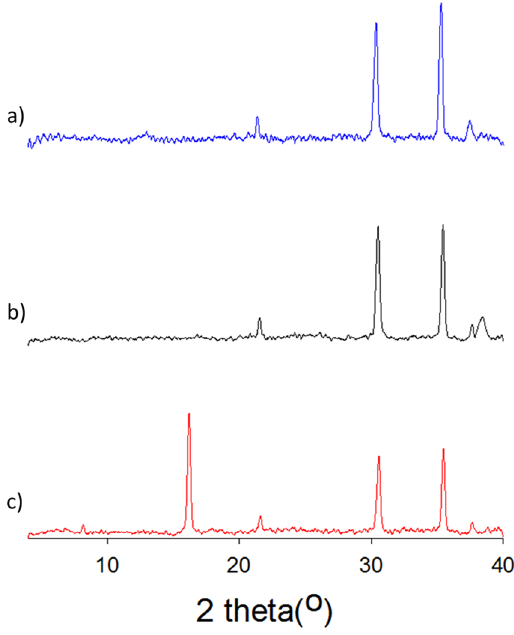
Figure 5. XRD patterns of ( a ) ITO/PEDOT:PSS substrate; ( b )) same + as deposited film of D (30 nm); ( c ) same after 5 min TT at 140 °C.